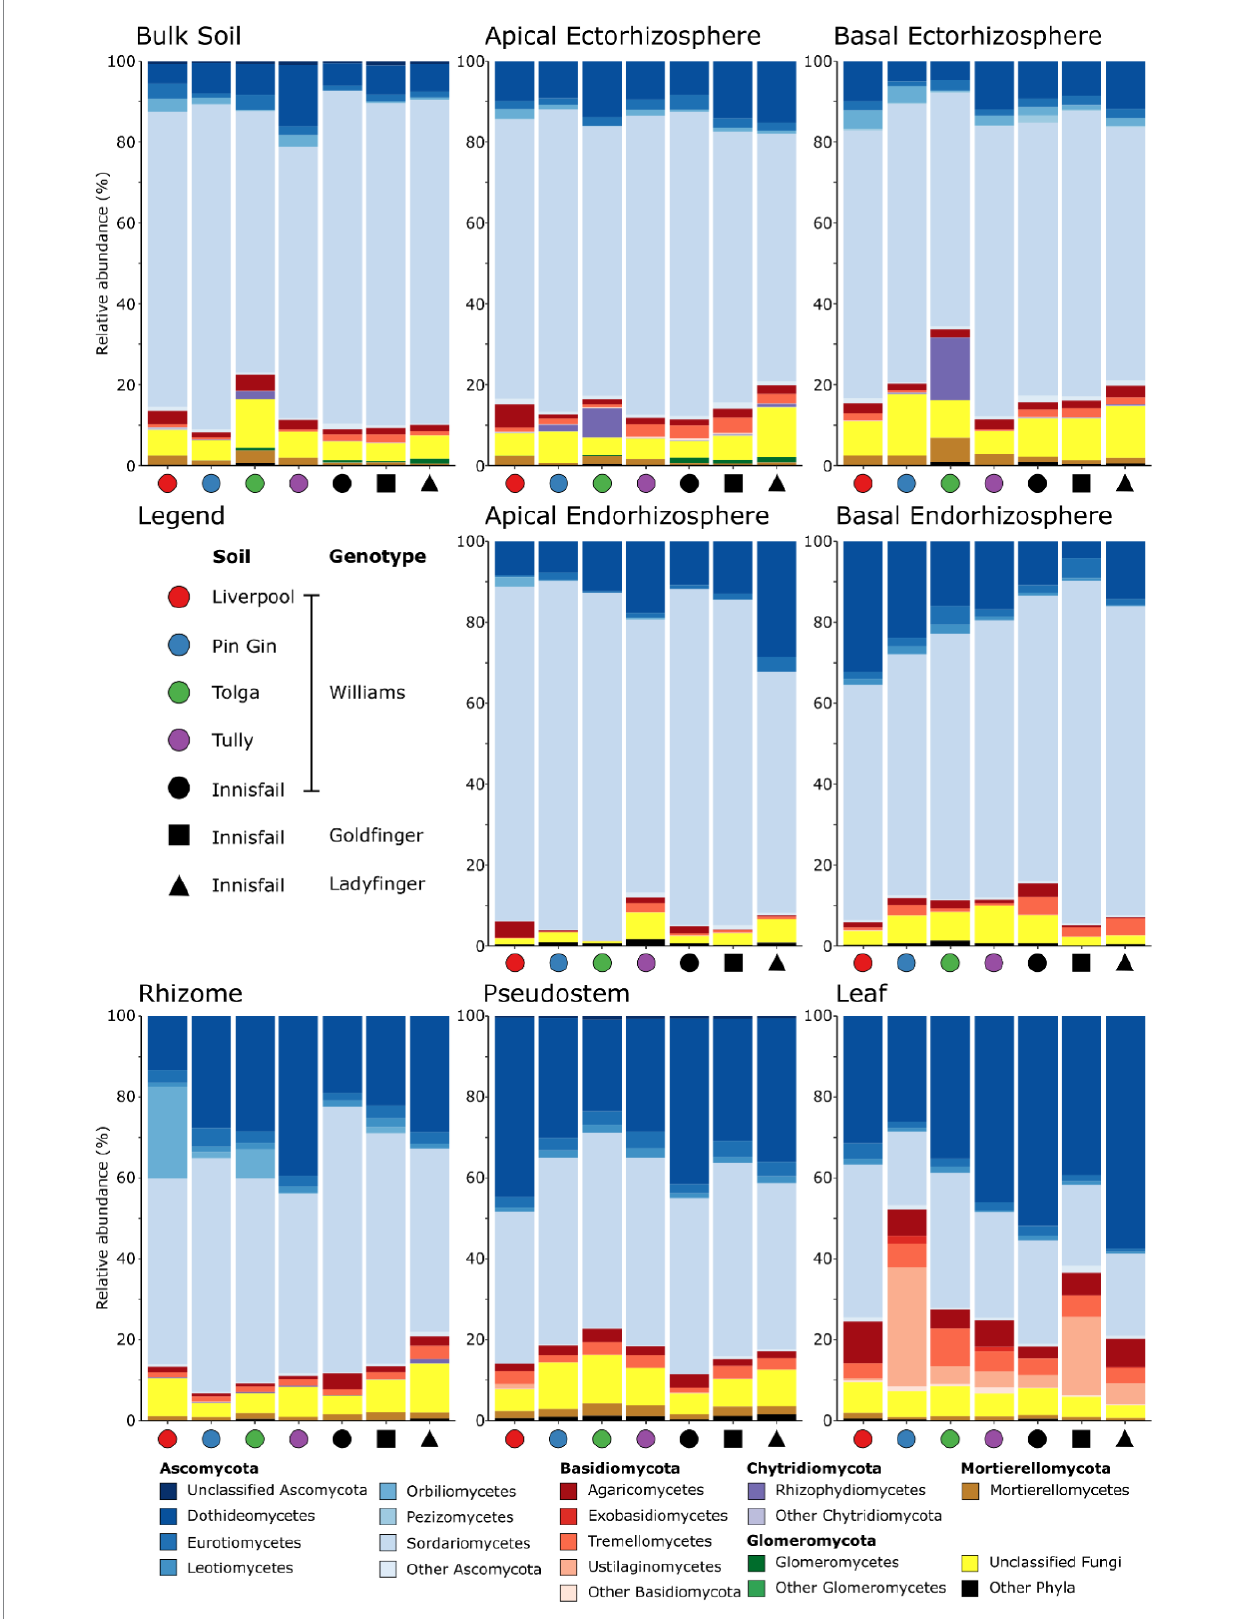
FIGURE 3 The mean relative frequencies of fungal classes in different plant compartments associated with Musa (AAA Group, Cavendish Subgroup) ‘Williams’ grown in pots with five distinct soils, and two other Musa spp. genotypes grown in pots containing an Innisfail series soil. Within each phylum, classes represented at <1% mean relative abundance are grouped as